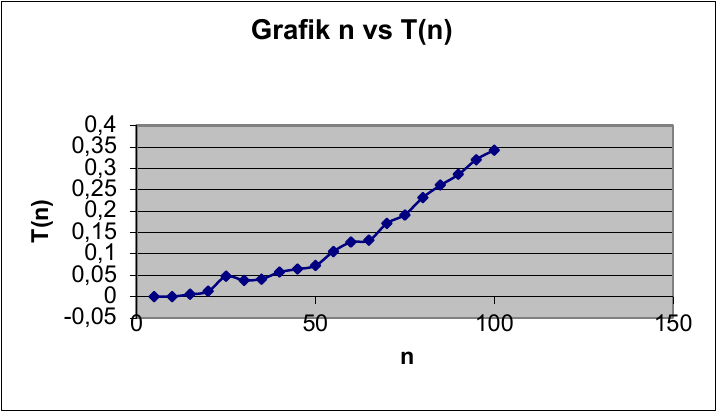
Figure 3. Graph of n vs T(n) in experiment